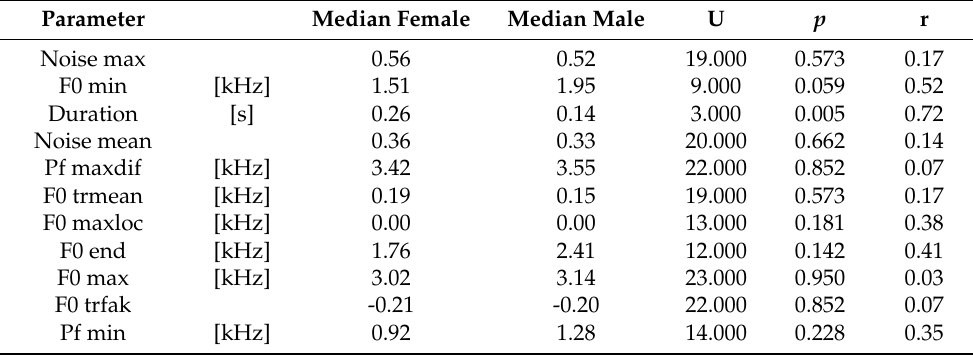
Table 4. Differences in the acoustic parameters used by the discriminant function analysis (DFA) between female and male calls using the Mann – Whitney U-test. Due to the no significant differences in all frequency parameters, we made no correction for multiple testing.